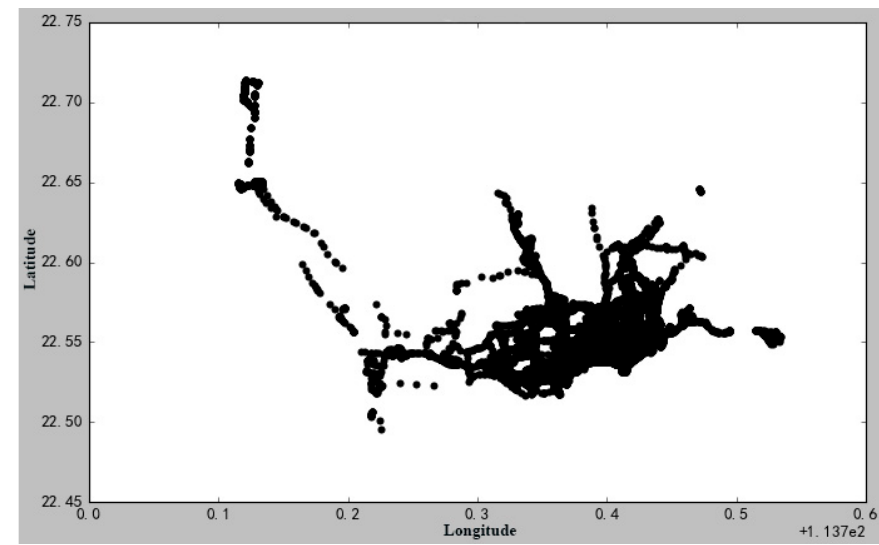
Figure 24. The trajectory distribution of the original data before clustering. Table 13. Results format after clustering